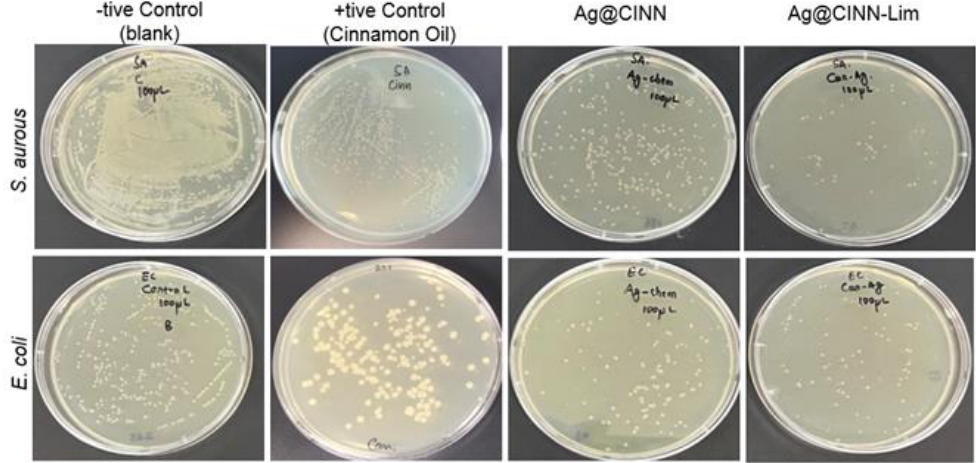
Figure 4. Photographic image of agar plate showing the intensity of bacterial colonies grown against each test.